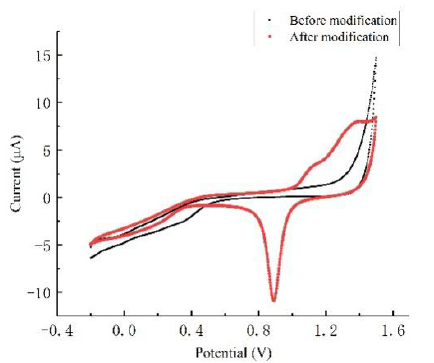
Figure 5. CV characteristic curve of the ultramicro electrode in H 2 SO 4 before and after modification.